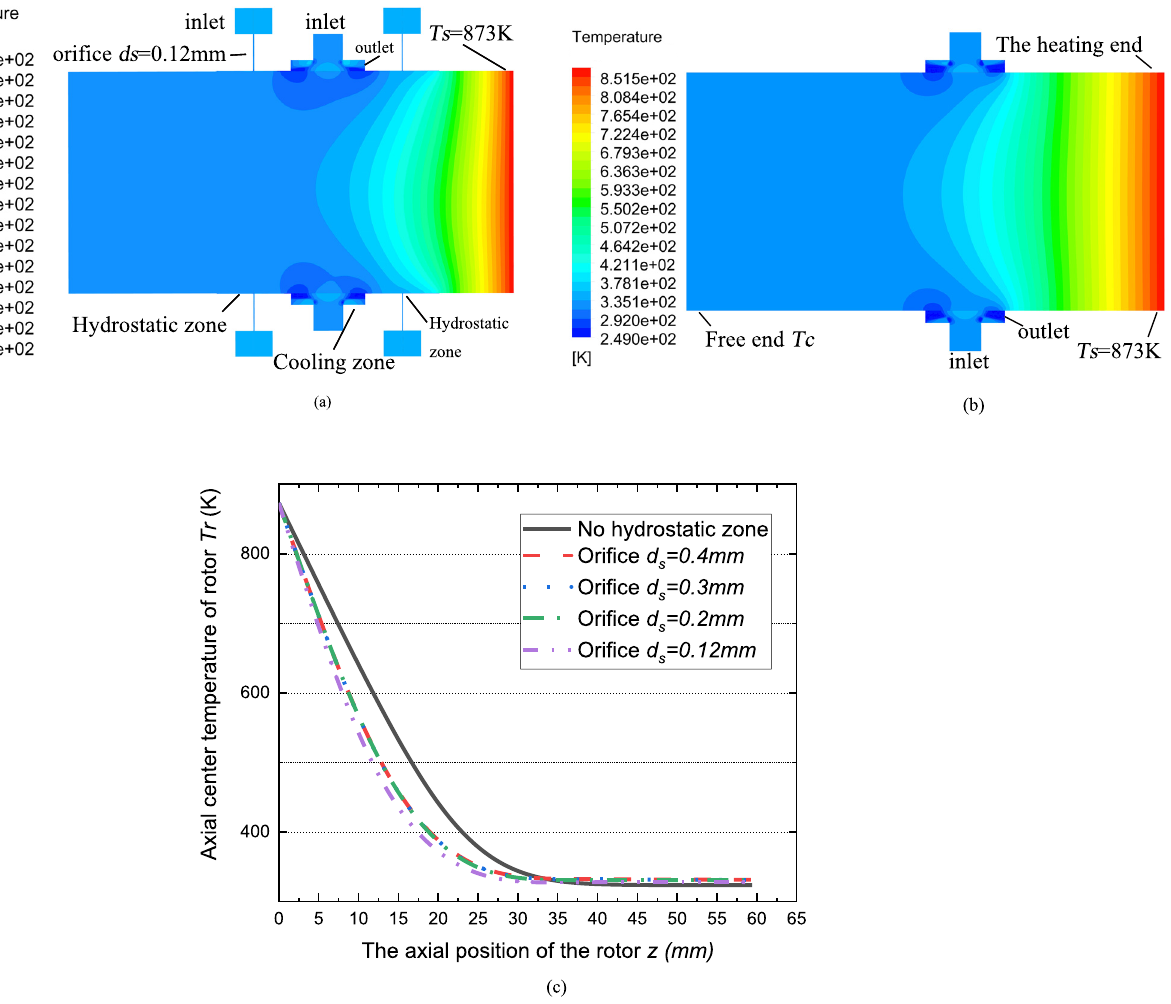
Fig. 12. Temperature distribution cloud map and gradient comparison chart, d in =4 mm, H g =1.5 mm, T CO 2 =350 K, P CO 2 =7 MPa. (a) With hydrostatic zone. (b) No hydrostatic zone. (c) Temperature gradient